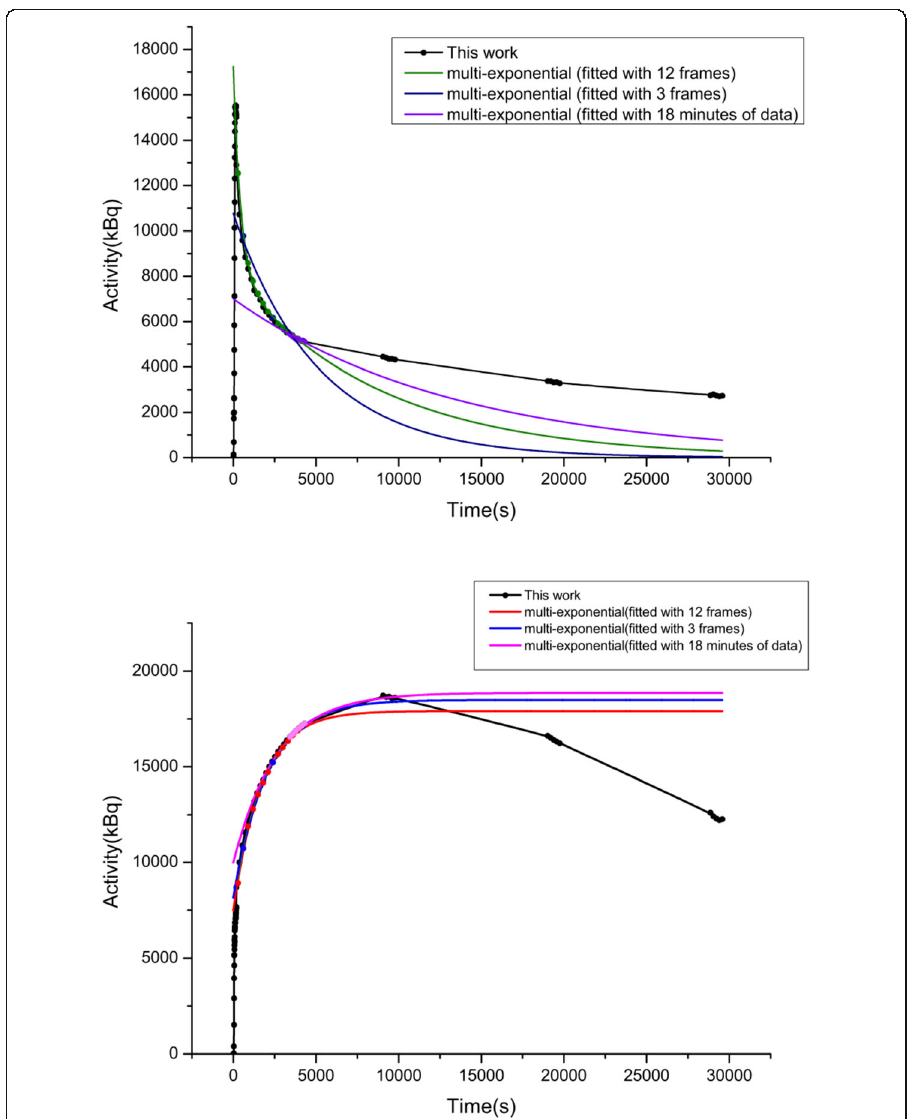
Fig. 2 A comparison between TAC generated between multi-exponential method with 12 × 120 s, 3 × 180 s, and 18 min of data (decay corrected) and spline method (8 h, both decay corrected and not decay corrected) in liver data (up) and brain data (down) fitting in one of the